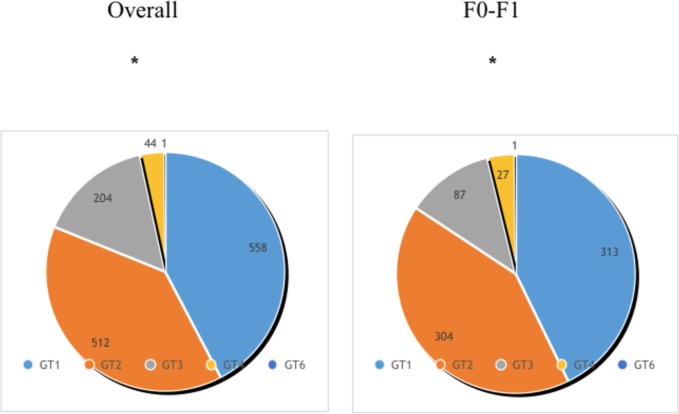
HCV genotype distribution overall and by F0/F1.The figure demonstrates that all the genotypes but GT5 are represented in this real world cohort. GT1 and GT2 were the most frequent accounting for 42% and 39% respectively. This proportion was maintained when 732 patients with F0-F1 stage of fibrosis were analyzed separately (42.7% were GT1 and 41.5% GT2).